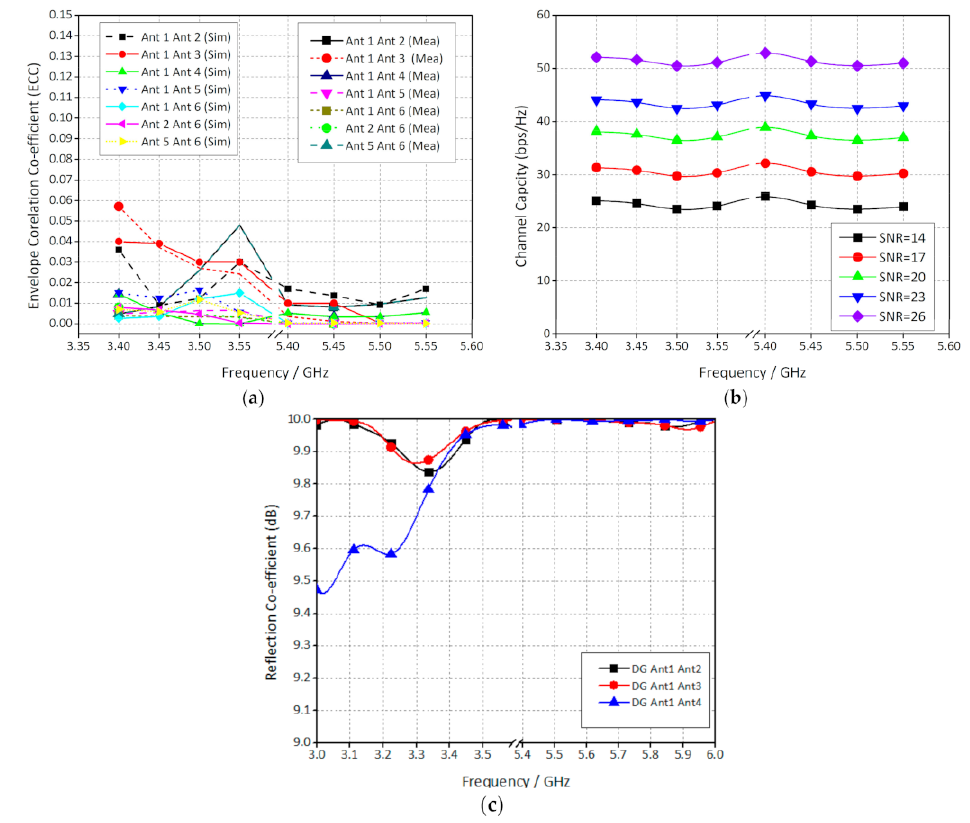
Figure 9. MIMO Parameters of proposed dual band Antenna. ( a ) ECC ( b ) Channel Capacity ( c ) Diversity